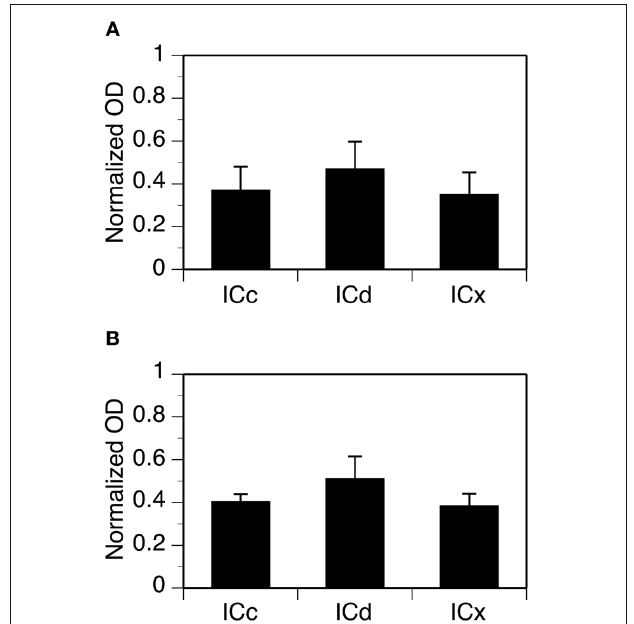
FIGURE 4 | Group results from immunohistochemical experiments showing overall (cell body and neuropil combined) levels of GABA B R1 and GABA B R2 immunoreactivity (A and B) in three subdivisions of the IC. For each section in an animal, a normalized OD was obtained for each of the alternating grid boxes. A mean normalized OD value was obtained for each collicular subdivision of an animal. Each bar in a bar chart represents a grand mean value for four animals for a subdivision. Error bars indicate standard errors.